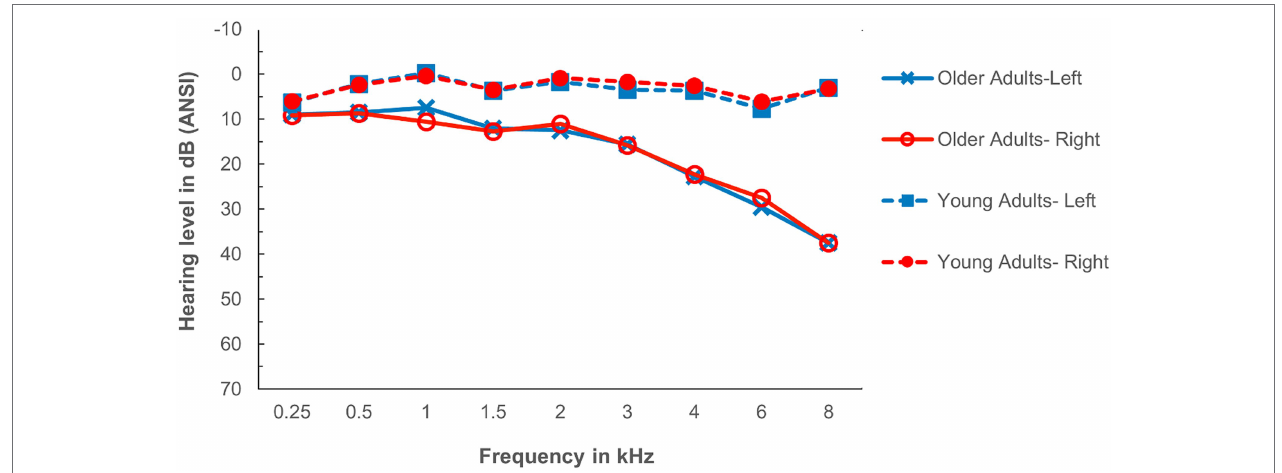
FIGURE 2 | Average audiograms for the two age groups (Young vs. Older adults). Left and right ears are plotted